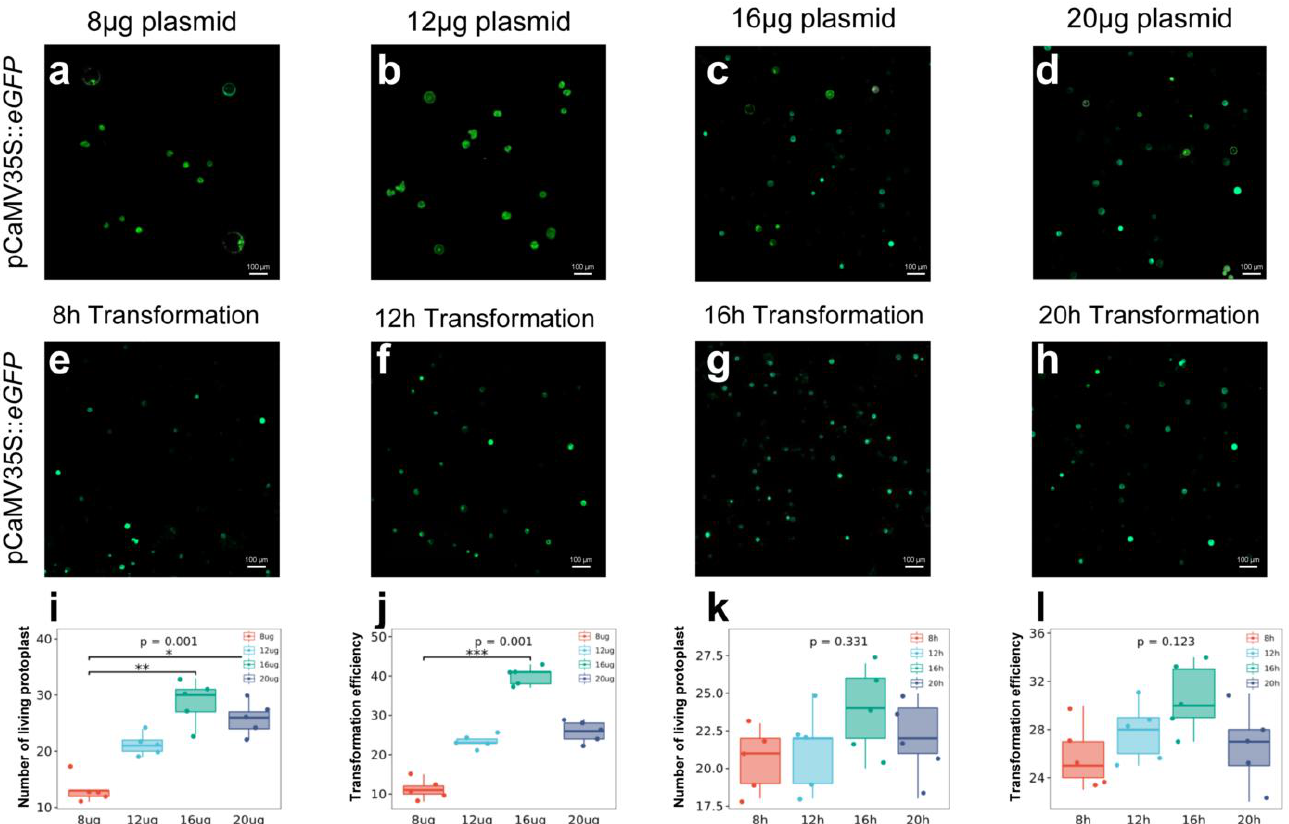
Figure 6. Effects of plasmid concentration and transformation time on protoplast transformation efficiency. Fluorescence microscope images of protoplasts transformed using different ( a – d ) plasmid concentrations and ( e – h ) transformation times. Scale bars = 100 μm. ( i ) The number of fluorescent protoplasts per unit area after transformations were performed with different plasmid concentrations ( p = 0.001). ( j ) Protoplast transformation efficiency per unit area after transformations were performed with different plasmid concentrations ( p = 0.001). ( k ) The number of fluorescent protoplasts per unit area after transformations were performed with different transformation times ( p = 0.331). ( l ) Protoplast transformation efficiency per unit area after transformations were performed with different transformation times ( p = 0.123). * p < 0.05, ** p < 0.01, *** p < 0.001 (Dunn’s test).